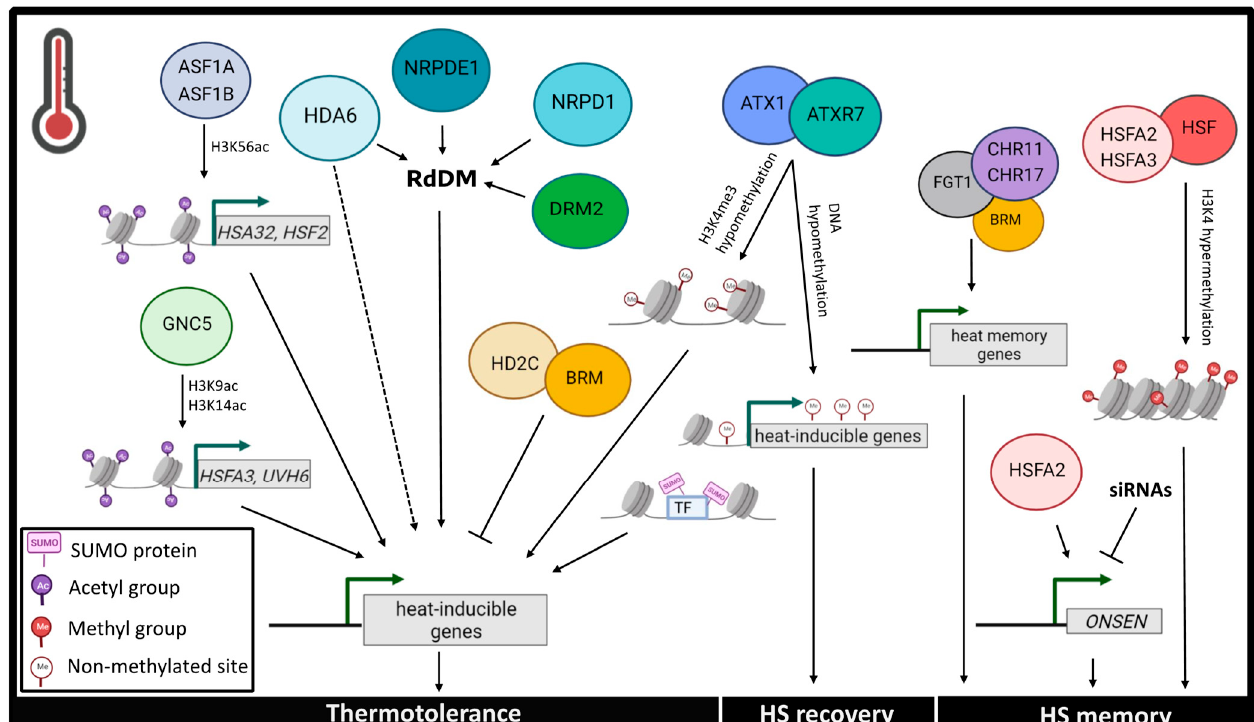
Figure 2. Epigenetic events controlling temperature responses to heat stress. Plants utilize epigenetic mechanisms such as histone modifications, chromatin remodeling and DNA methylation to cope with heat stress and acquire heat stress memory. Epigenetic marks contributing to thermotolerance include H3K9, H3K14 and H3K56 acetylation, H3K4 hypomethylation, de novo DNA methylation mediated through the RdDM pathway and chromatin SUMOylation. DNA hypomethylation of heat inducible genes is an essential step in HS recovery, while chromatin remodeling, HSFs and H3K4 hypermethylation contribute to the acquisition of HS memory. Dotted lines symbolize unknown factors involved in the pathway illustrated. Heat Stress (HS), Heat Shock Factors (HSF), RNA-directed DNA Methylation (RdDM). The figure was created in BioRender.